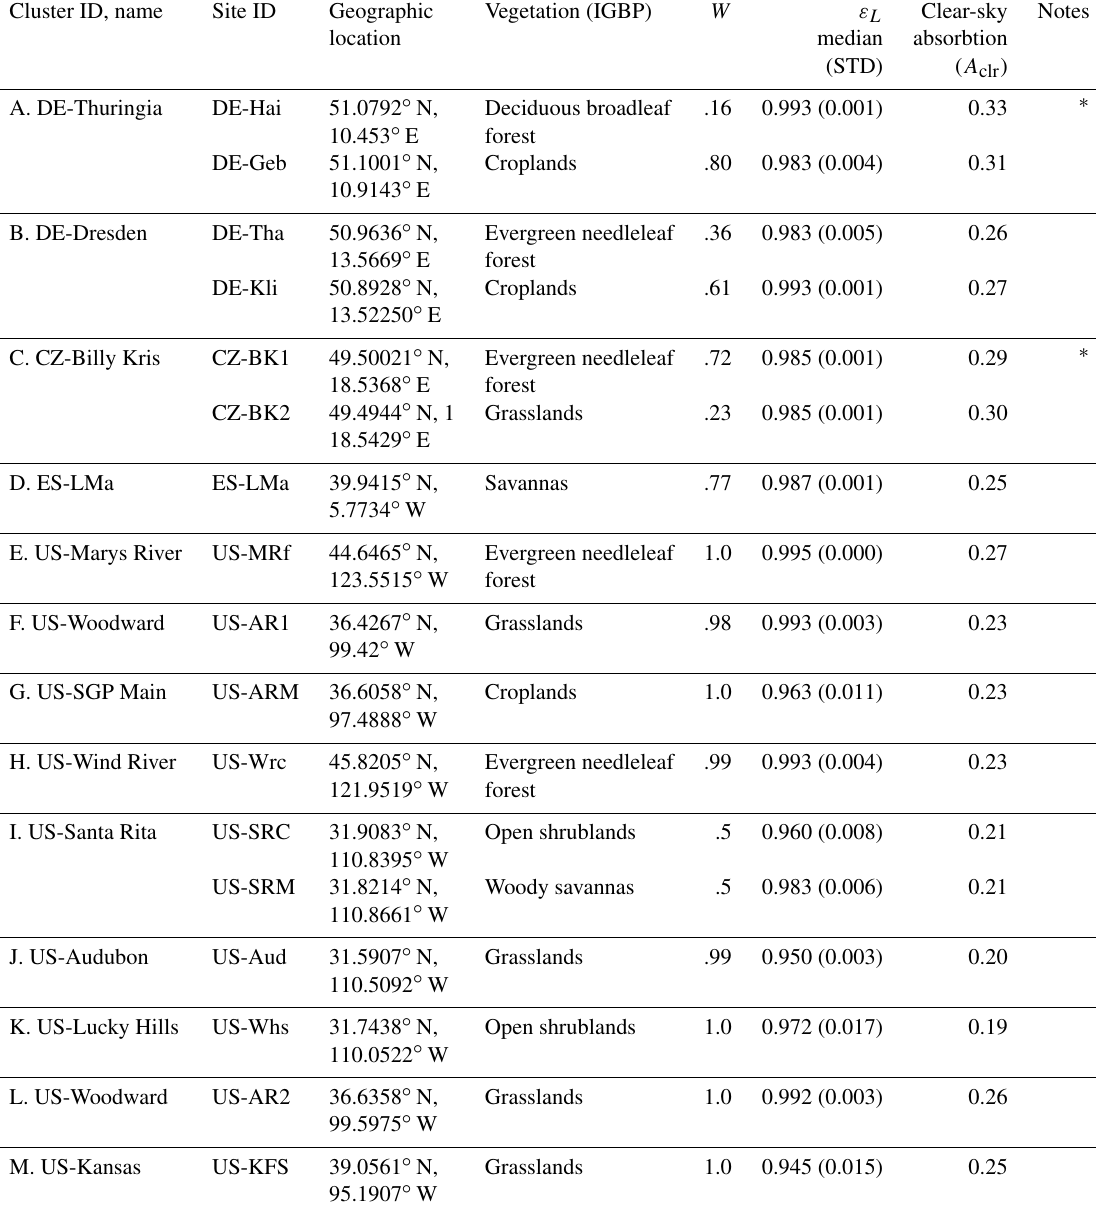
Table 1. List of ground validation targets detailing geographic location and International Geosphere-Biosphere Programme (IGBP) vegetation type. Local parameters determined for each station are weight ( W ) in spatial average, longwave emissivity and clear-sky